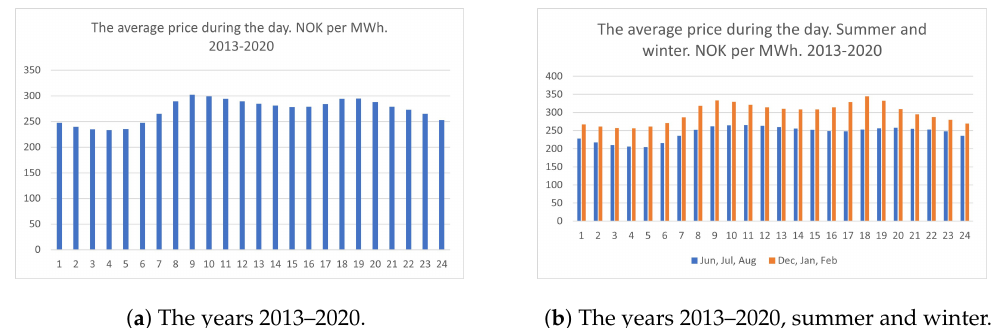
Figure 8. Average electricity price during the day ( a ) in the period of 2013–2020 and in the summer (June, July and August) and in the winter (December, January, February) in the period of 2013–2020 ( b ). NOK per